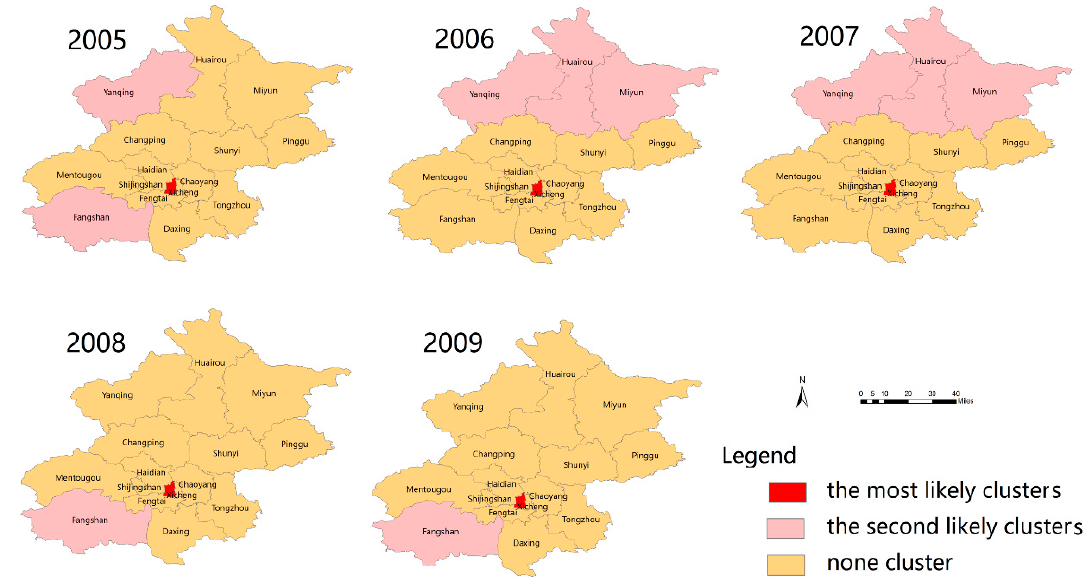
Figure 4. Cont Figure 4. Cont. Figure 4. Cont.